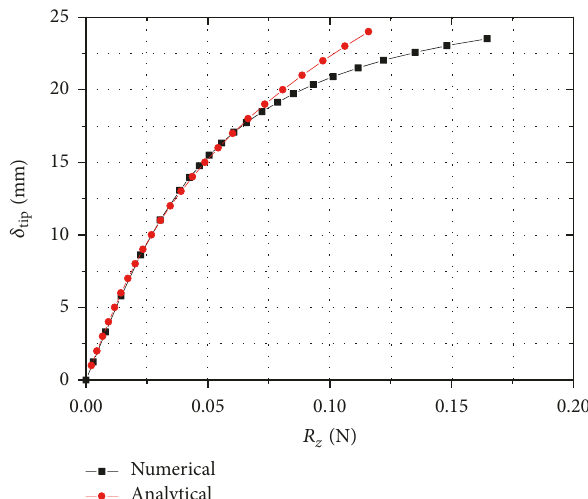
Figure 7: FE-based capacity curve and analytical